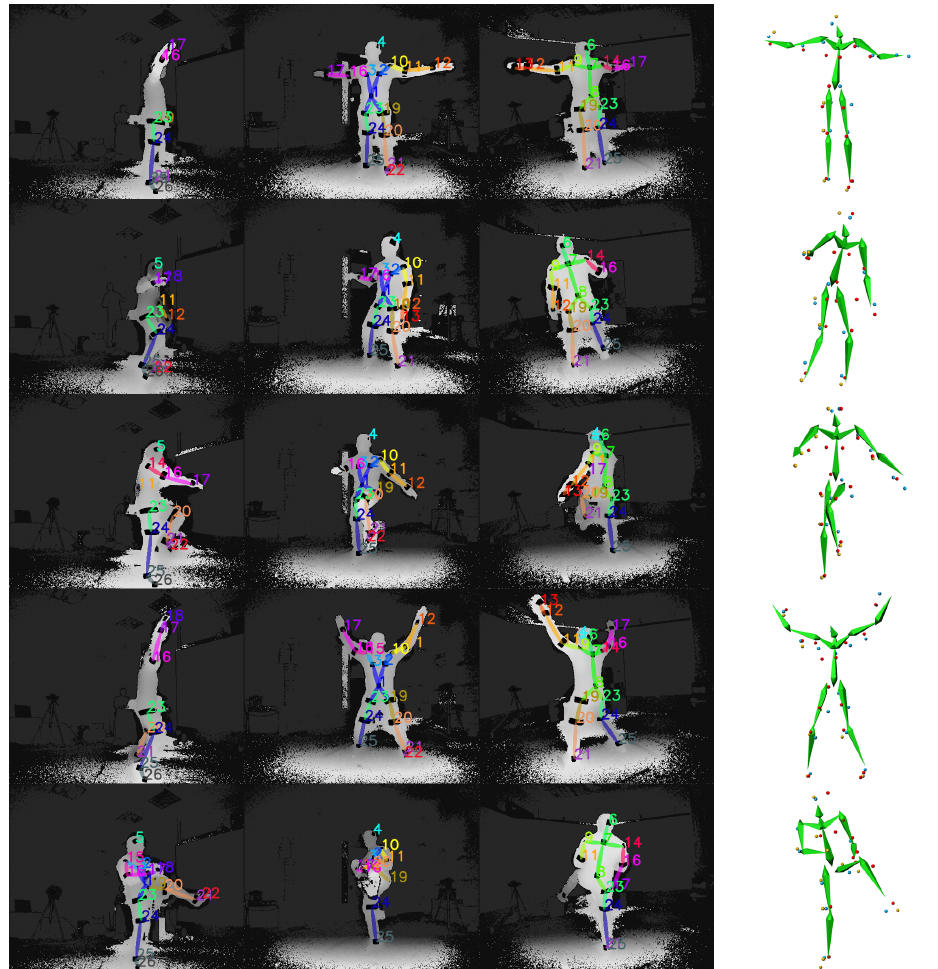
Figure 15. Five samples of the method results are illustrated in rows. At the left side of the figure, the multi-view input along with the FCN reflector-set estimates are presented, while, at the right side, their corresponding 3D optical and motion capture outcomes are